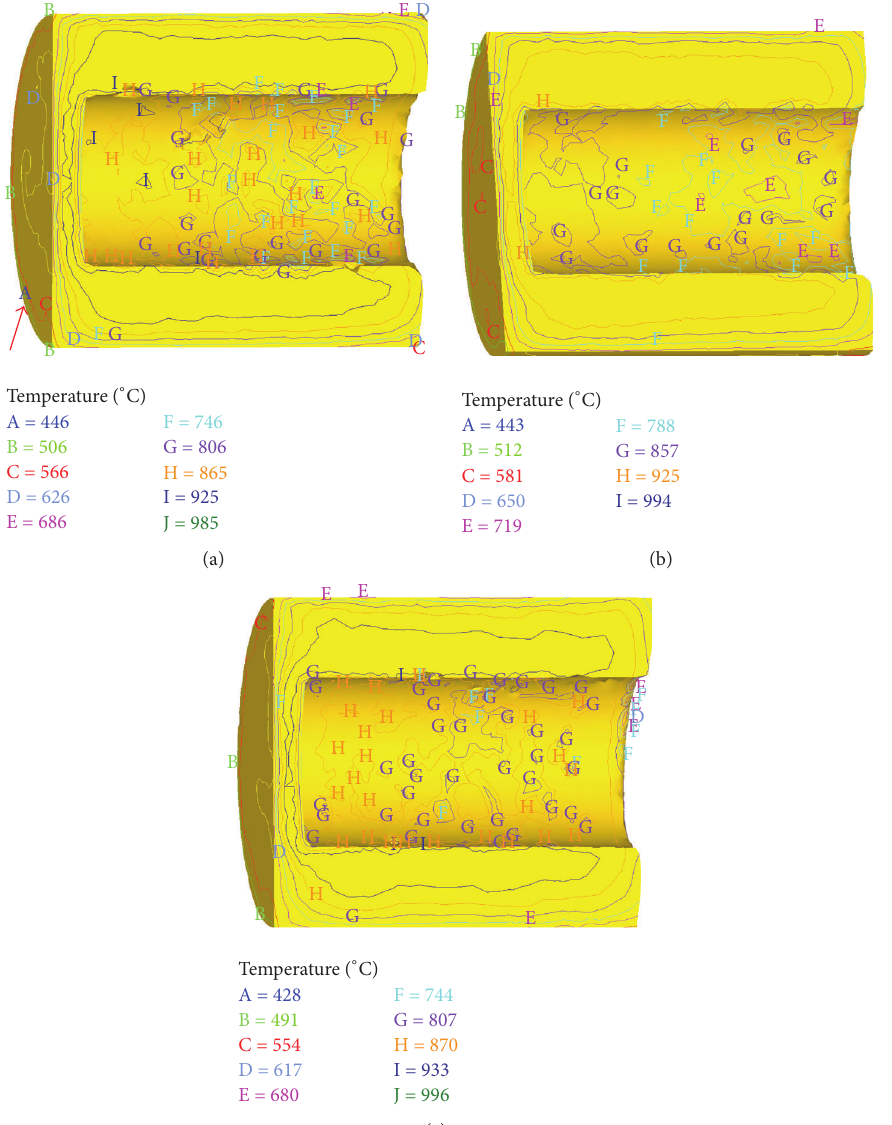
Figure 9: Temperature distribution of billet deformed at the piercing speed of (a) 50mm/s, (b) 80mm/s, and (c) 100mm/s.